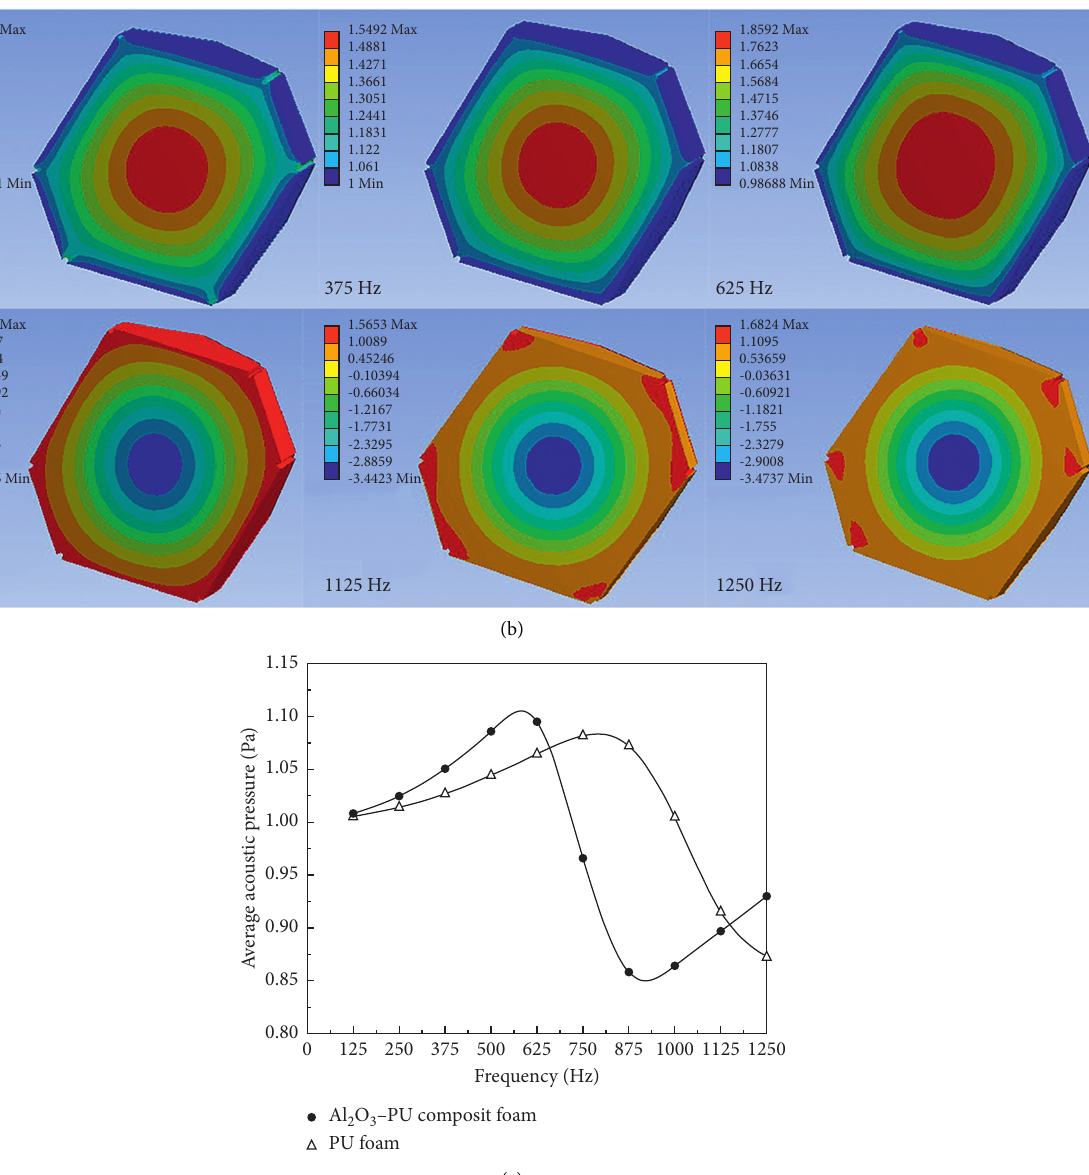
Figure 5: (a) PU foam and (b) Al 2 O 3 /PU foam acoustic cavity section sound pressure topography in 125Hz, 375 Hz, 625Hz, 875Hz, 1125Hz, and 1250Hz. (c) The average sound pressure change curve of PU foam and Al 2 O 3 /PU